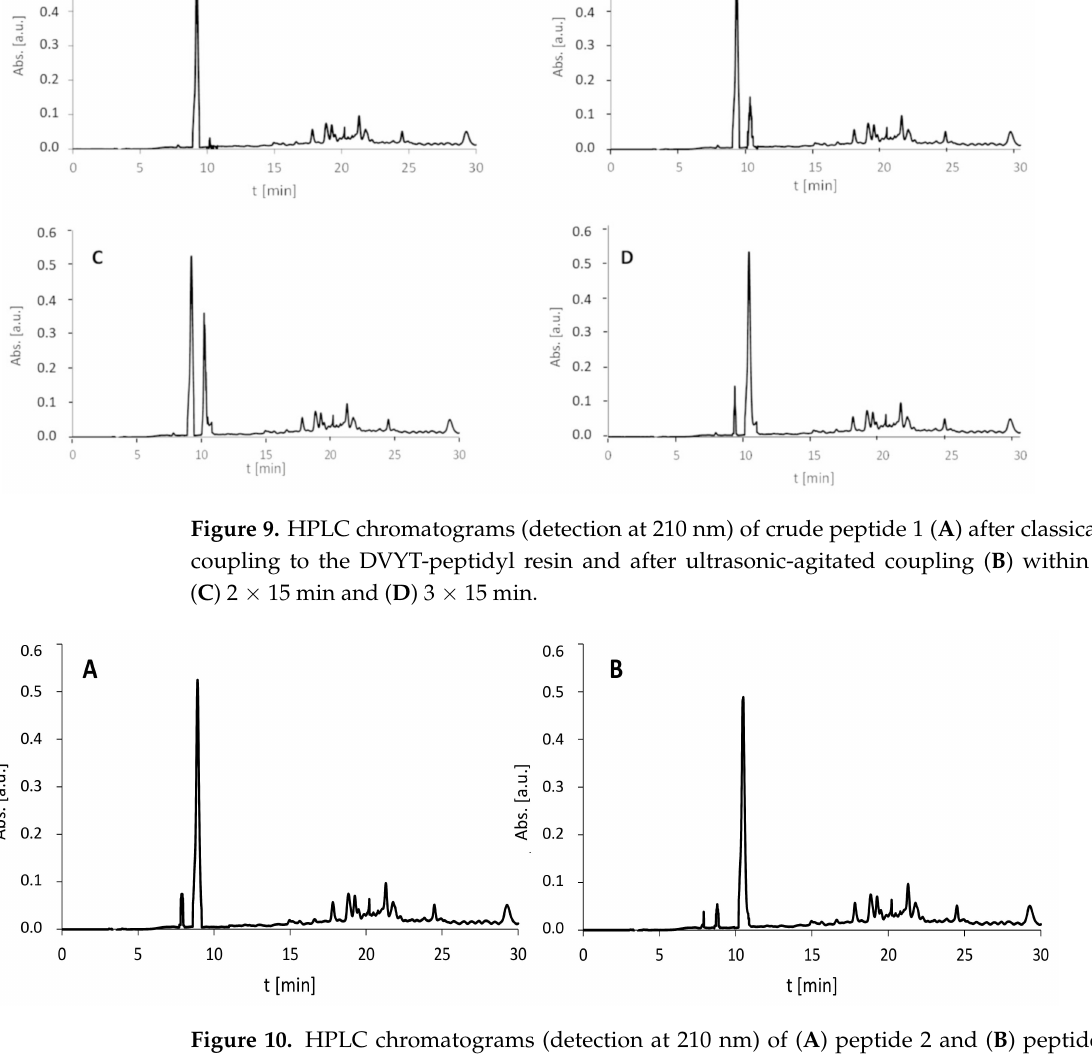
Figure 10. HPLC chromatograms (detection at 210 nm) of ( A ) peptide 2 and ( B ) peptide 3 after ultrasonic-agitated coupling within 3 × 15 min. ( A ) The model peptide with H-EAAA-NH 2 and peptide 2 (H-AMIA-EAAA-NH 2 ) were characterized by the retention time at 7.9 min and 8.9 min, as follows. ( B ) The model peptide with H-PPPP-NH 2 and peptide 3 (H-AMIA-PPPP-NH 2 ) were identified in the fractions characterized by the retention time at 8.8 min and 10.5 min, as